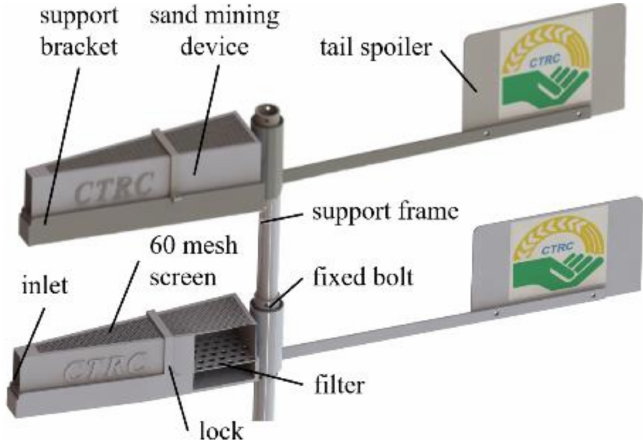
Figure 2. Schematic diagram of sand dust